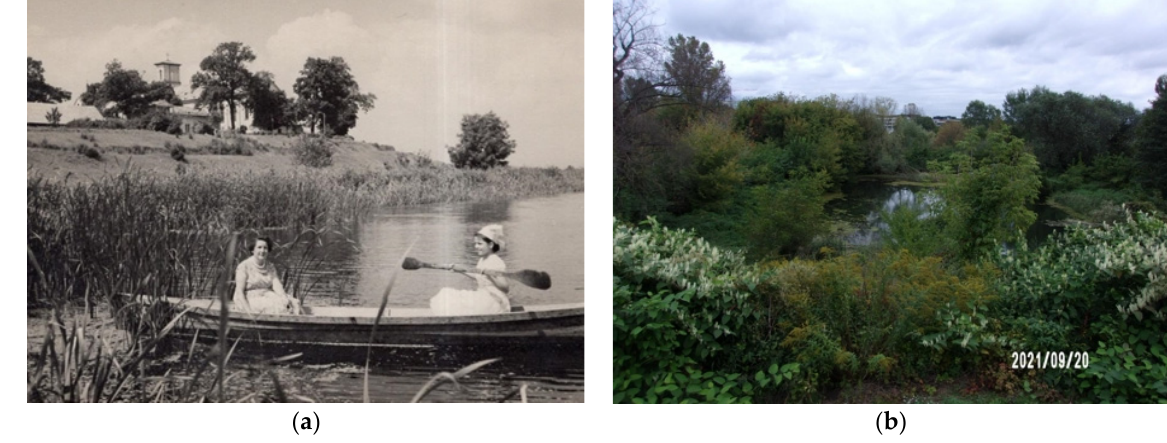
Figure A9. Priest’s Pond ( a ) historical (left) and ( b ) and contemporary (right) view.